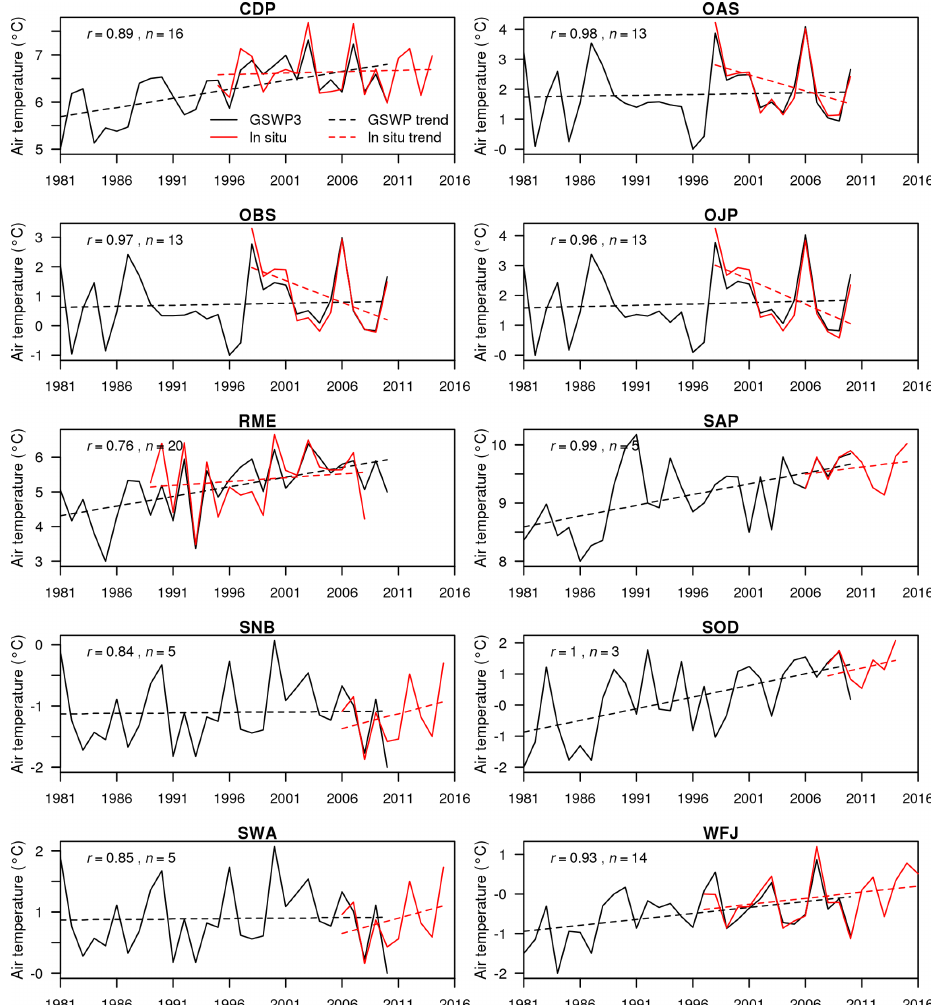
Figure 10. Annual mean temperatures and fitted trends for years starting on 1 October at reference sites from GSWP3 and in situ data. Numbers show correlation ( r ) between GSWP3 and in situ air temperature for the n complete years of